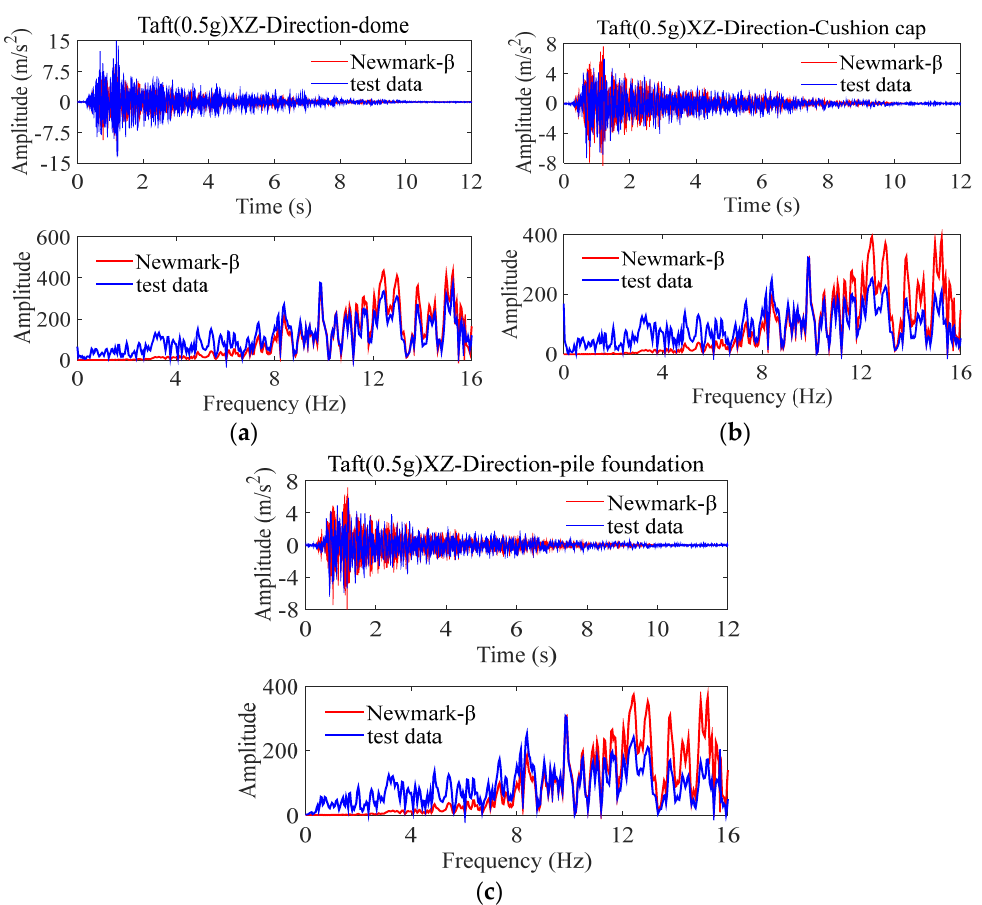
Figure 9. Comparison of shaking table test data and theoretical solution under the El − Centro wave: ( a ) dome acceleration time history and spectrum comparison; ( b ) cushion cap acceleration time his- tory and spectrum comparison; ( c ) pile foundation acceleration time history and spectrum compar- ison.